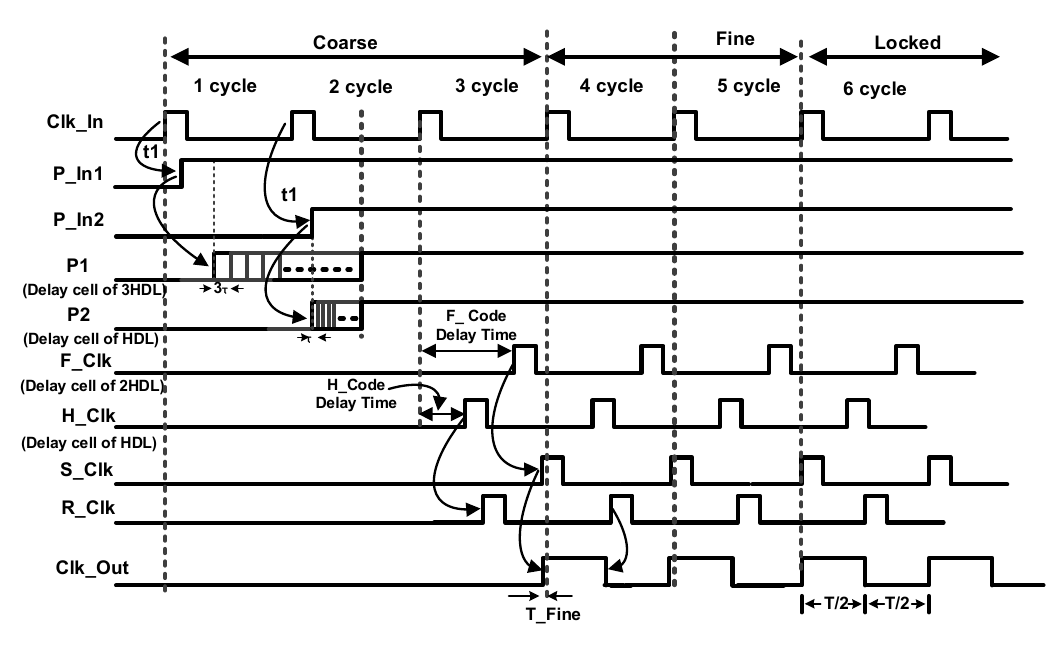
Figure 3. Time diagram of proposed circuit .